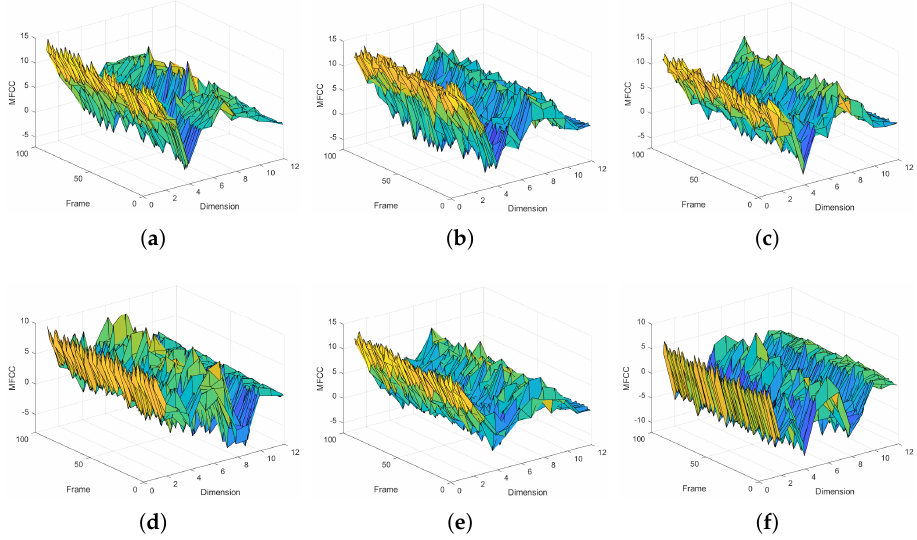
Figure 10. MFCC of transformer acoustic with different faults. ( a ) Large load start or internal short circuit. ( b ) Severe internal short circuit. ( c ) Internal breakdown short circuit. ( d ) Poorly grounded iron core. ( e ) Loose silicon steel or coil. ( f ) High voltage.